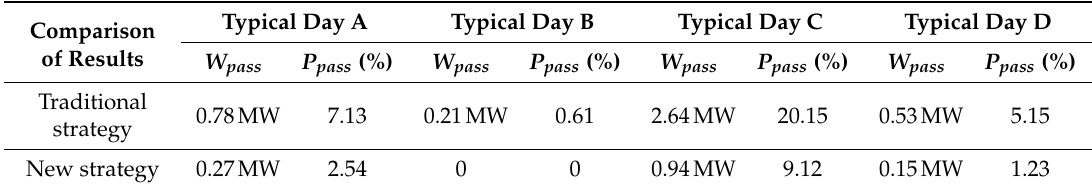
Table 1. Comparison of the moderating e ff ects of the two strategies on wind-solar power fluctuation on typical days A, B, C, and D.